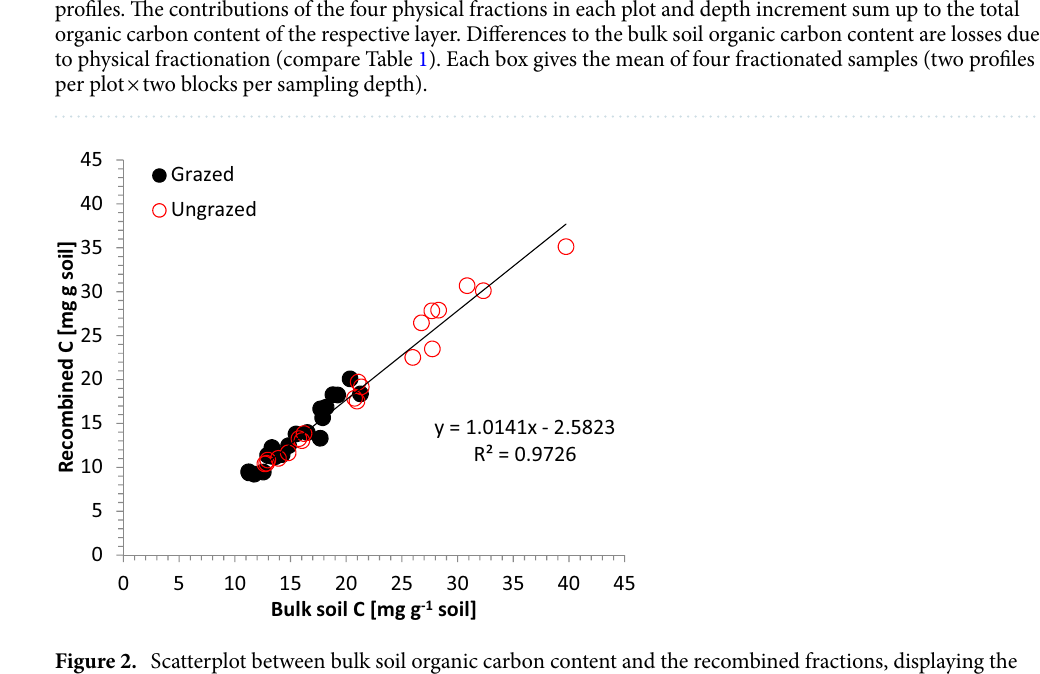
Figure 2. Scatterplot between bulk soil organic carbon content and the recombined fractions, displaying the recovery of the physical fractionation